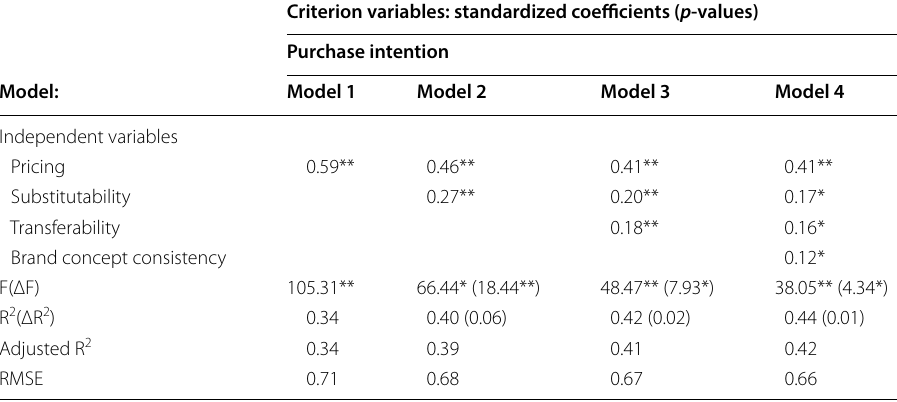
** Significant at the p-value < 0.01. * Significant at the p-value <